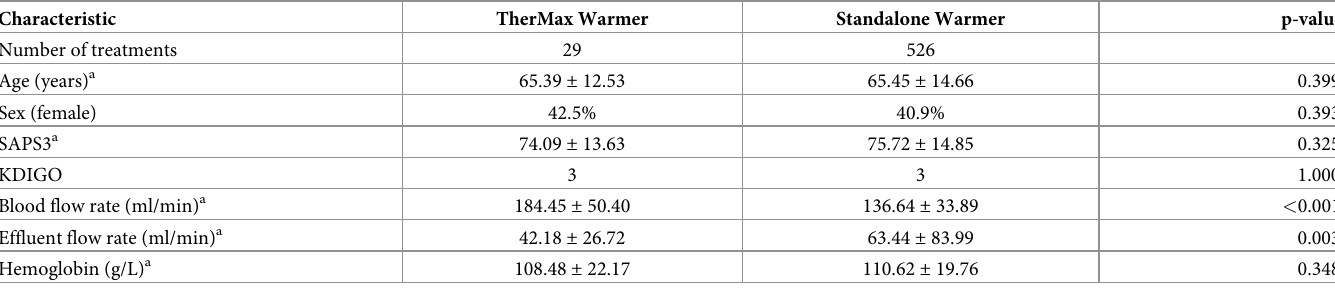
Table 1. Baseline demographic and clinical characteristics.